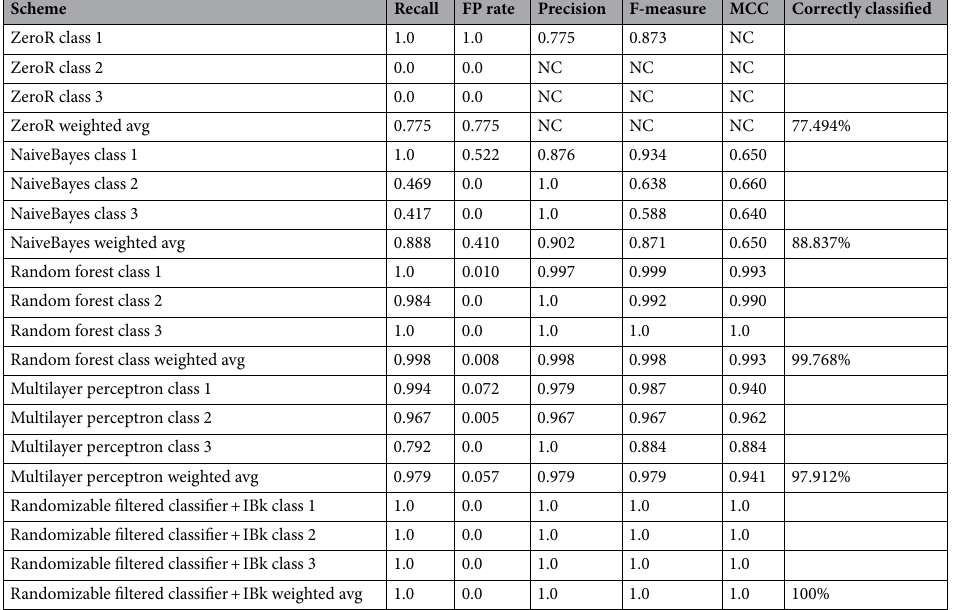
Table 2. Supervised learning results on the right eye. FP false positive, MCC Matthews correlation coefficient, avg . average, NC not calculable.